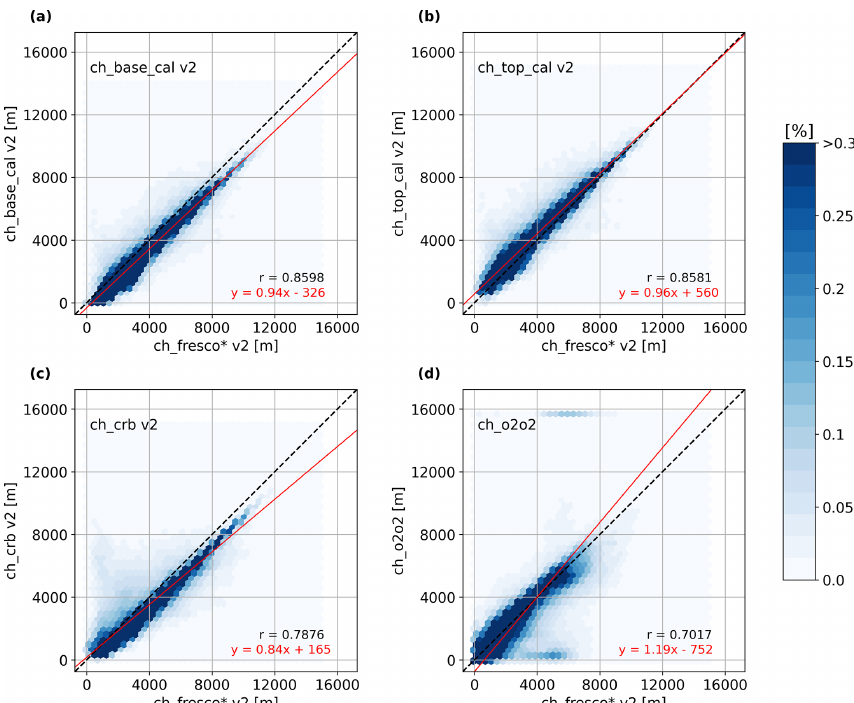
Figure 12. Density histograms between the version 2 (a) ROCINN CAL CBH, (b) ROCINN CAL CTH, (c) ROCINN CRB CH, and (d) O 2 – O 2 CH and the FRESCO CH from the TROPOMI NO 2 product (ch_fresco*) for China and the autumn day (20 September